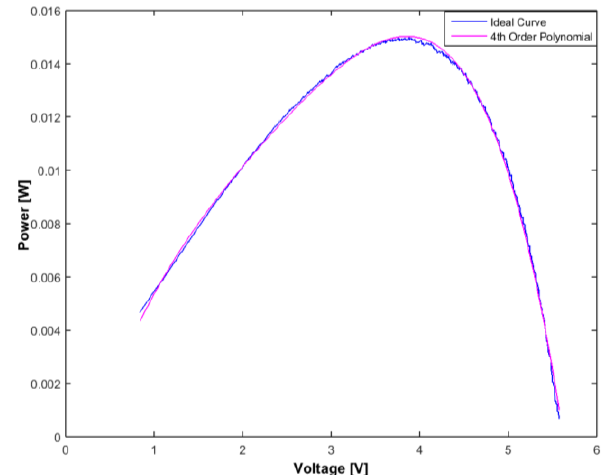
Figure 11 . I-V curve with 4th order polynomial fitting. Figure 11 presents the current-voltage (I-V) curve fitting with fourth order polynomial method. Here the I-V curve of blue colour is obtained from the ideal measured values. And the other I-V curve is the curve obtained by fourth order polynomial fitting on the ideal value. From the figure we can see that the curve obtained by polynomial fitting is almost in line with the curve of ideal measured value.